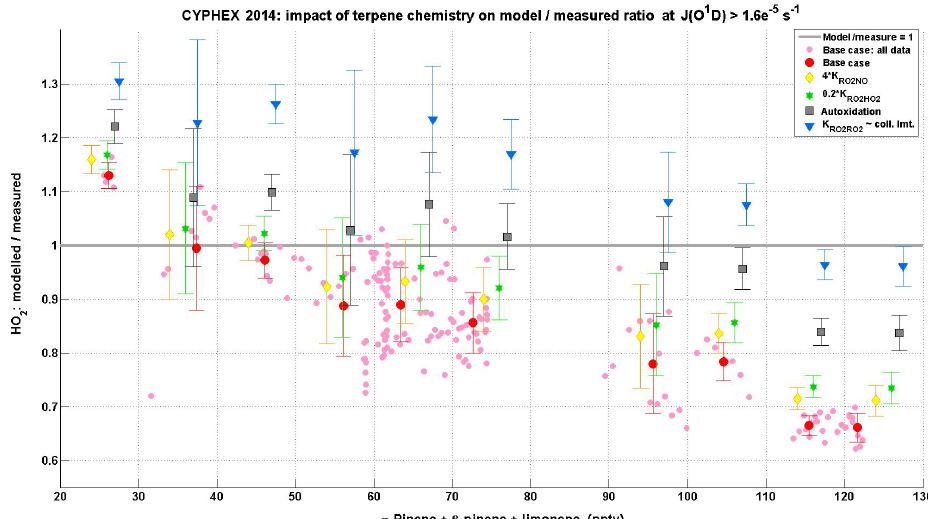
Figure 6. HO 2 predictions using different chemical schemes which were employed to investigate the impact of peroxy radicals as a HO 2 sink. The x axis shows the sum of measured α -pinene, β -pinene, and limonene. The base case is the model simulation using measured species; 4 × K RO is a simulation in which the rates of selected terpene-related RO 2 species with NO are increased by a factor of 4; 0 . 2 × K RO 2 NO is a simulation in which the rates of these RO 2 species with HO 2 are reduced by a factor of 0.2; the autoxidation simulation includes an autoxidation scheme rapidly converting selected RO 2 species into ROOH. The last scheme refers to a simulation in which K RO to 4 × 10 − 10 cm 3 molecule − 1 s − 1 (close to the collision limit). The mean and sigma are calculated for 100pptv bins along the x